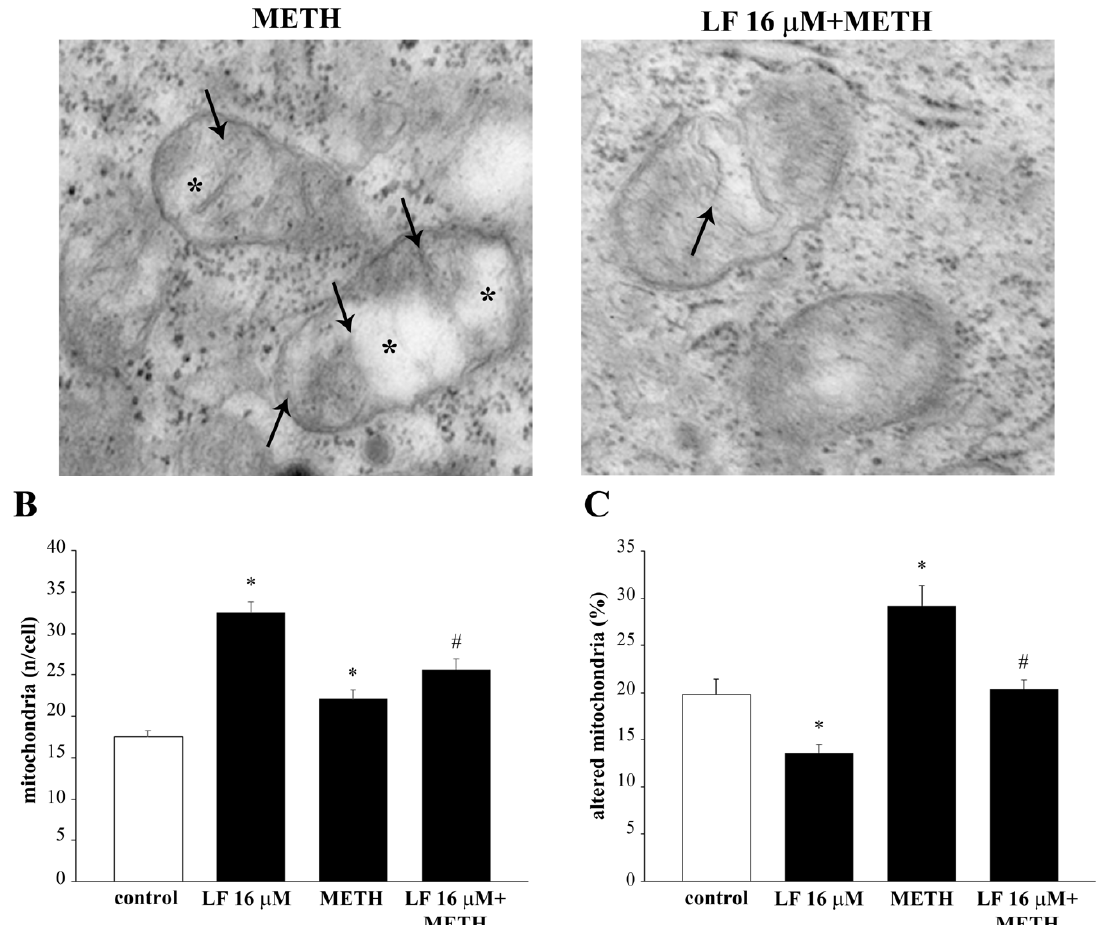
Figure 10. LF prevents METH-induced alteration of mitochondrial structure and number. ( A ) Representative micrographs showing mitochondria from a control cell and from cells treated with either LF, or METH, or combined LF + METH. Note the ultrastructure of well-preserved mitochondria from controls and LF-treated cells. After, METH mitochondria show crest fragmentation (arrows) and matrix dilution (*). These effects are attenuated by previous LF administration, which mitigates mitochondrial crest derangement (arrow). The histograms report ( B ) the number of mitochondria per cell and ( C ) the percentage of altered mitochondria following various treatments. * p < 0.05 compared with control; # p < 0.05 compared with METH. Scale bar = 90 nm.